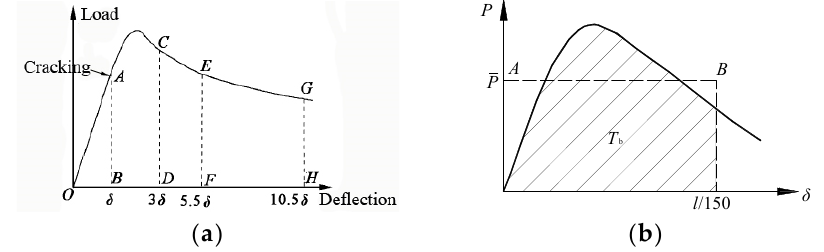
Figure 9. Existing flexural toughness evaluation methods: ( a ) ASTMC-1018; ( b ) JSCE-SF4.